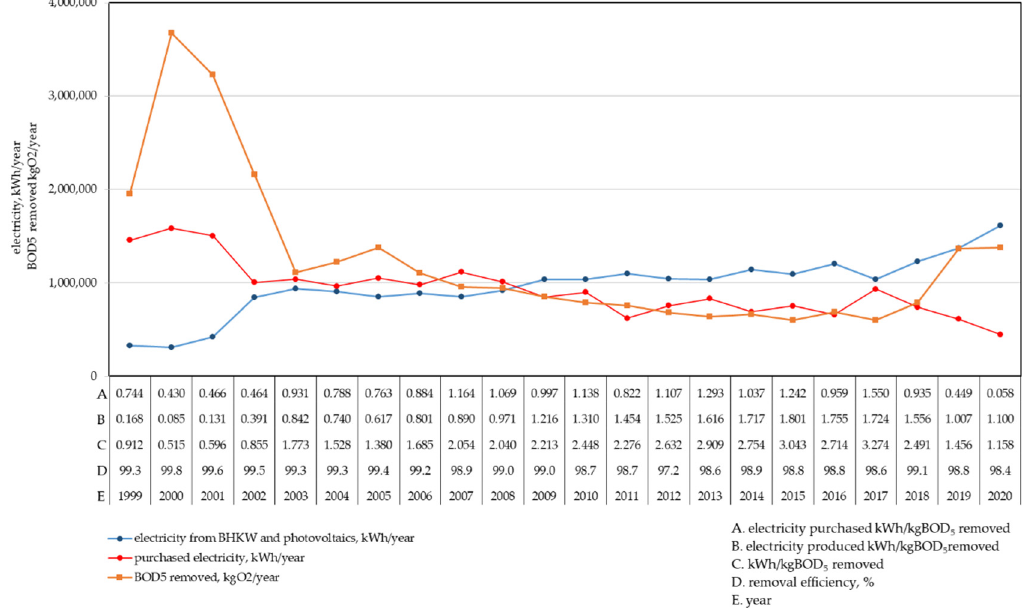
Figure 9. Amount of energy produced in BHKW and photovoltaic plant system, electricity purchased and BOD 5 removed in the years 2000 – 2020 .